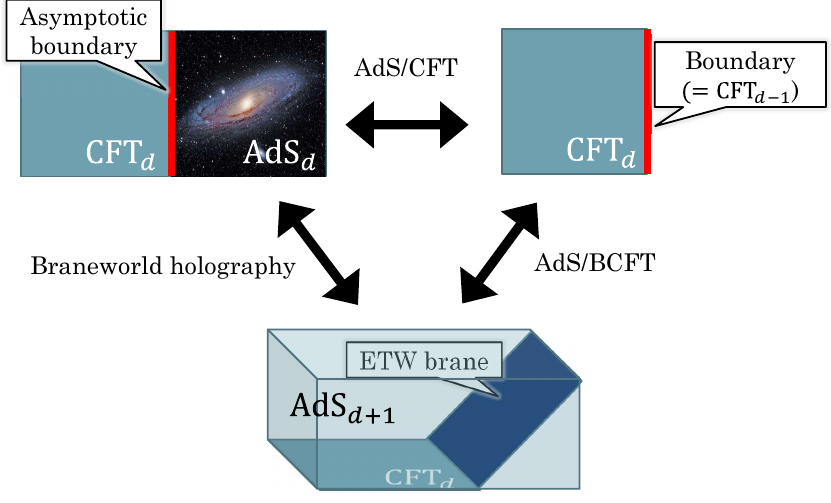
Figure 1 . Triality through the AdS/CFT correspondence. The CFT drawn in the left is dual to the BCFT drawn in the right through the AdS/CFT correspondence. Moreover, the BCFT is dual to the quantum gravity shown at the bottom through the AdS/BCFT correspondence. There is also a relation between the left picture and the bottom picture through the braneworld holography [17–19].